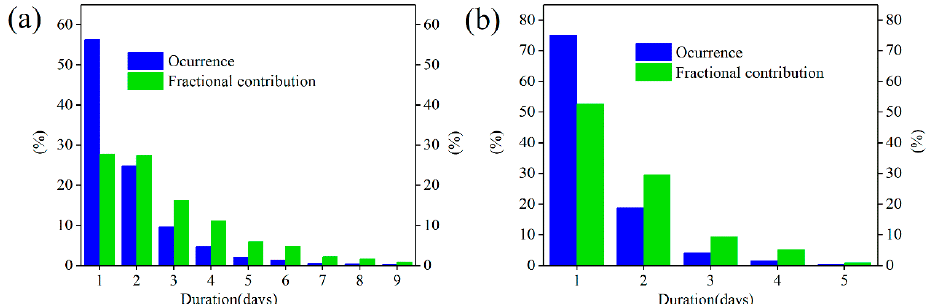
Figure 2. Occurrences and fraction contributions of wet period (WP) durations in the upper (UHRB) ( a ) and middle (MHRB) ( b ) reaches of the Heihe River Basin.